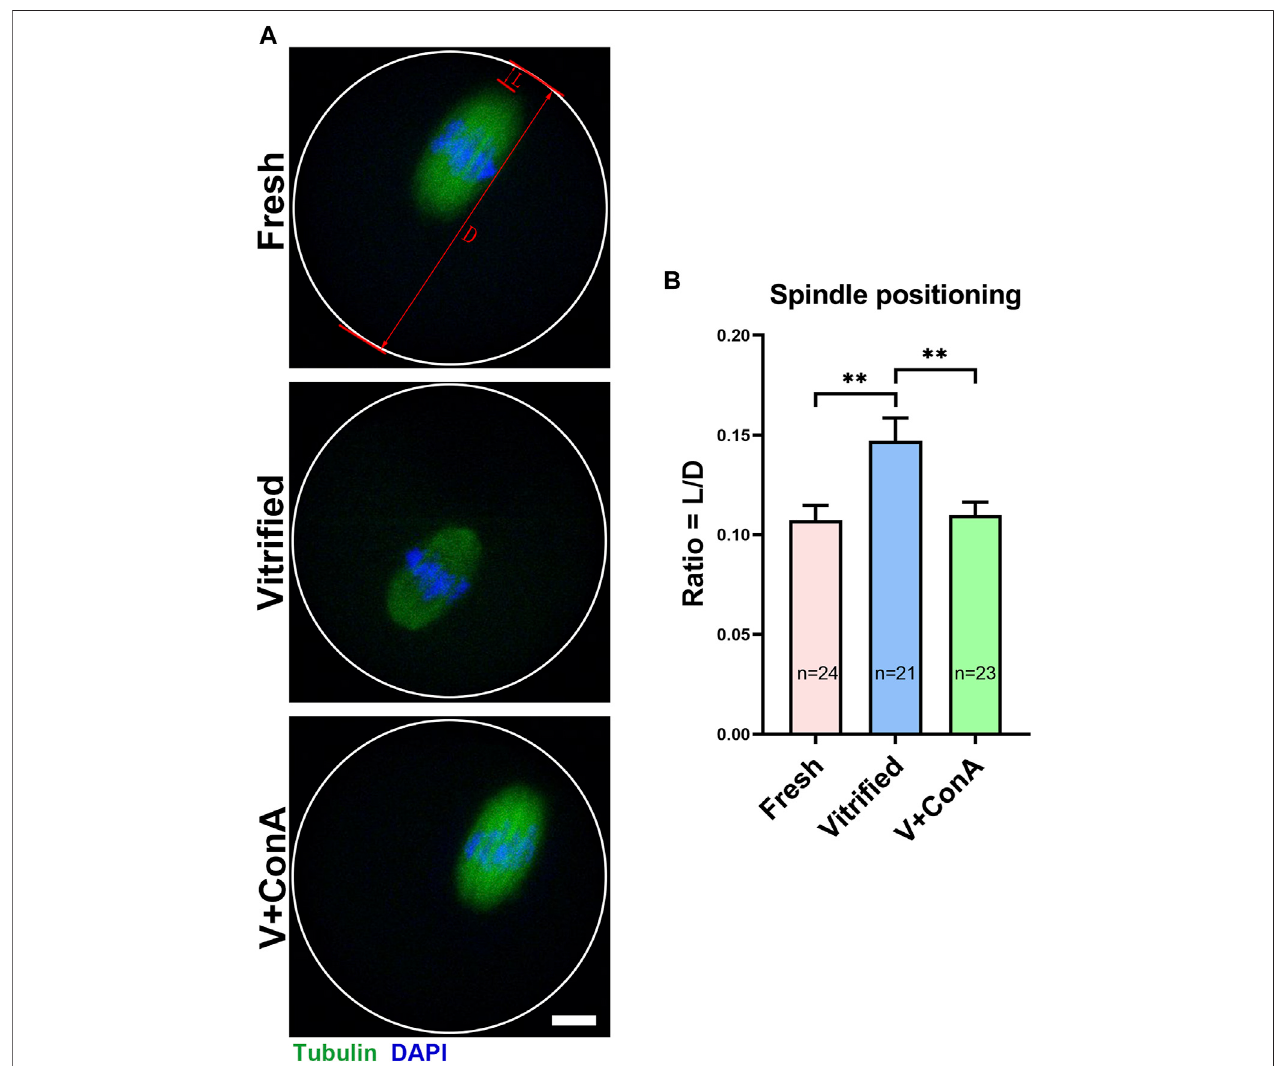
FIGURE 7 | Increasing cortical tension promoted spindle positioning in vitri fi ed oocytes. (A) Representative images of the spindle positioning in the fresh, vitri fi ed, andV+ConAoocytesafter9 hculture.Scalebar=10 μ m. (B) Quantitativeanalysisofthespindlepositioninginthefresh( n =24),vitri fi ed( n =21),andV+ConA( n =23) groups.L,lengthbetweenspindleleadingpoleandcortex;D,diameterofoocyte.Spindlepositioningwasde fi nedbytheraitooflengthbetweenspindleleadingpoleand cortex to diameter of oocyte. Data were presented as mean percentage (mean ± SEM) of at least three independent experiments. * p < 0.05, ** p < 0.01, *** p <